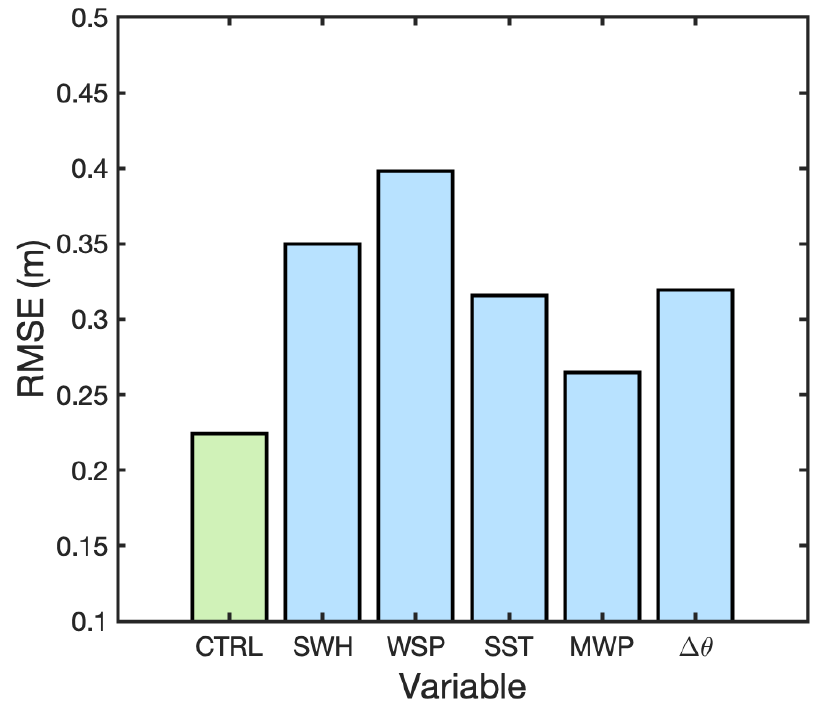
Figure 8. The RMSE for different variables in the permutation test. The CTRL is the initial RMSE without permutation test (green bar); the others are the RMSE of permutation tests on different variables (blue bar).